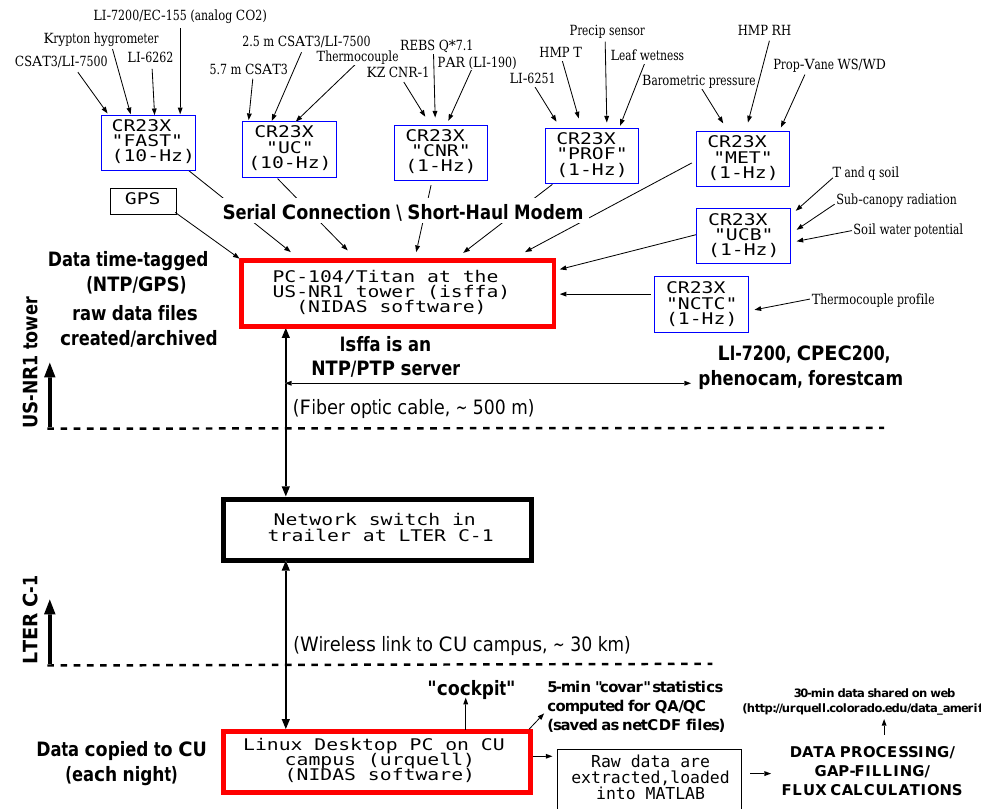
Figure 2. As in Fig. 1, except showing the data flow with the NIDAS data acquisition system, which was used starting on 20 October 2014. With the NIDAS system, the computer in the trailer at LTER C-1 (russter2) is replaced with a network switch/hub. The red boxes indicate high-rate data system components that are discussed within the text (Sect.